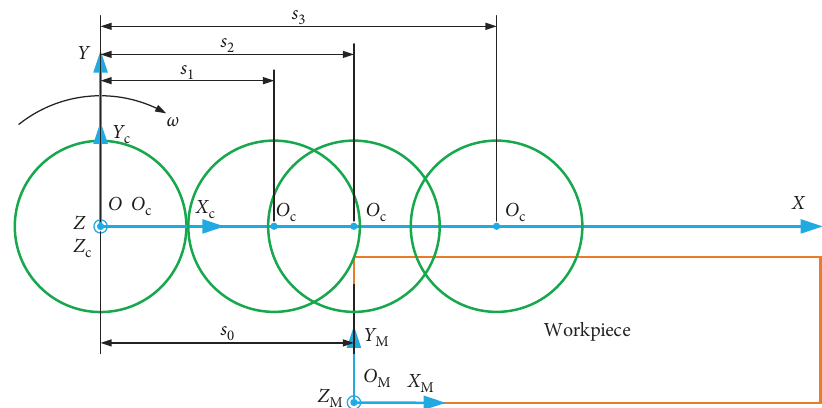
Figure 6: Cutter position and different contact